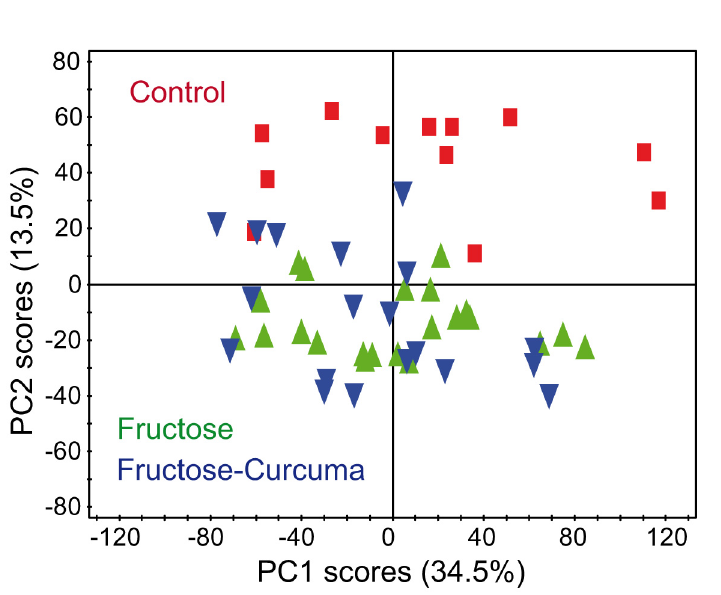
Fig 2. PCA score plot of the serum samples from Control, HFS and HFS+C groups.